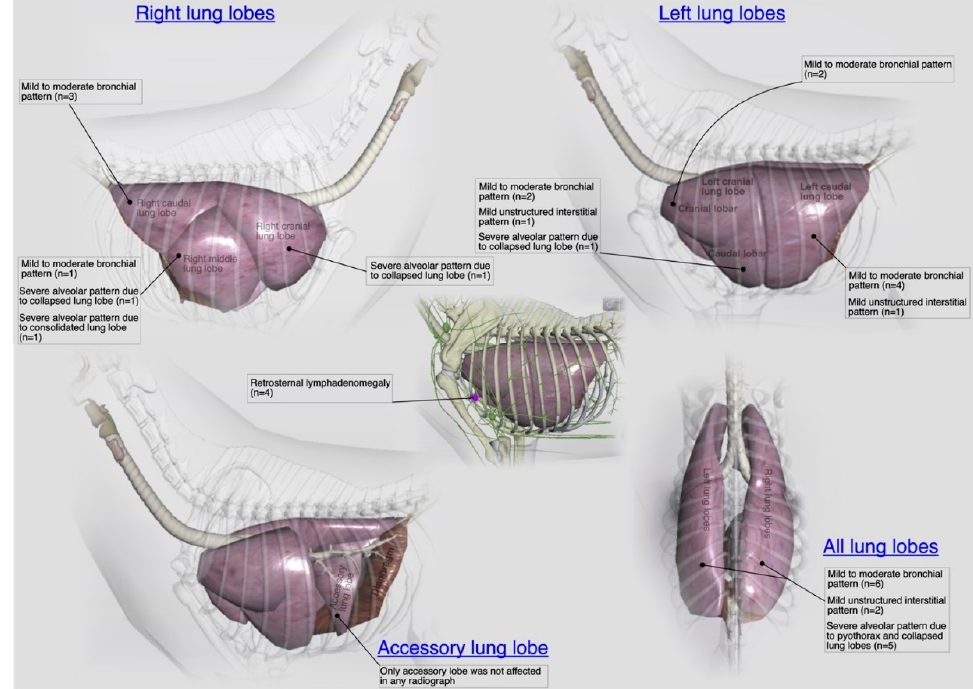
Figure 16. An illustrative summary of the localized radiographic abnormalities (patterns) of the pulmonary parenchyma (individual lung lobes and lobules) and their relevant blood vessels in terms of their laterality in a total of 27 cats presented with acute/chronic infectious respiratory disease signs.